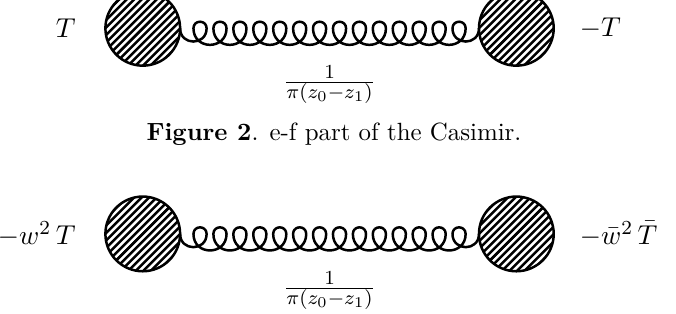
Figure 3 . f-e part of the Casimir.